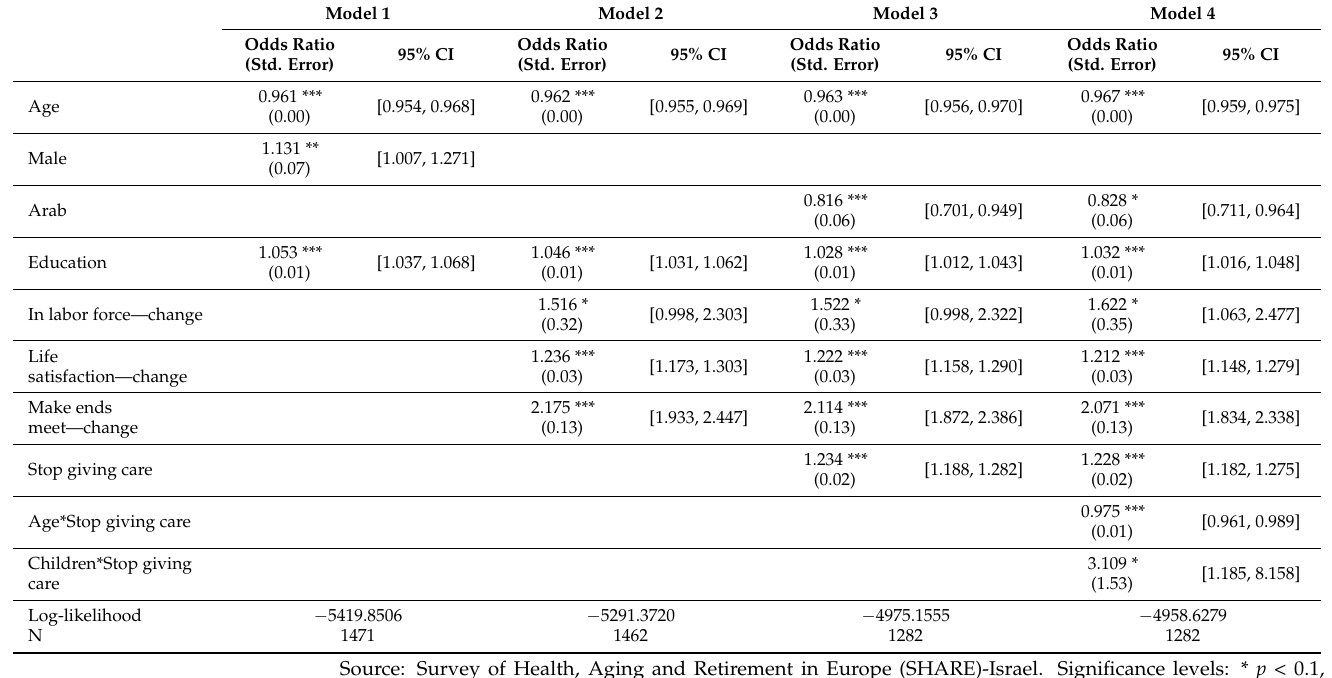
Table 3. Ordered logistic regression analysis with self-rated health as a dependent variable (odds ratio). Model 1 Model 2 Model 3